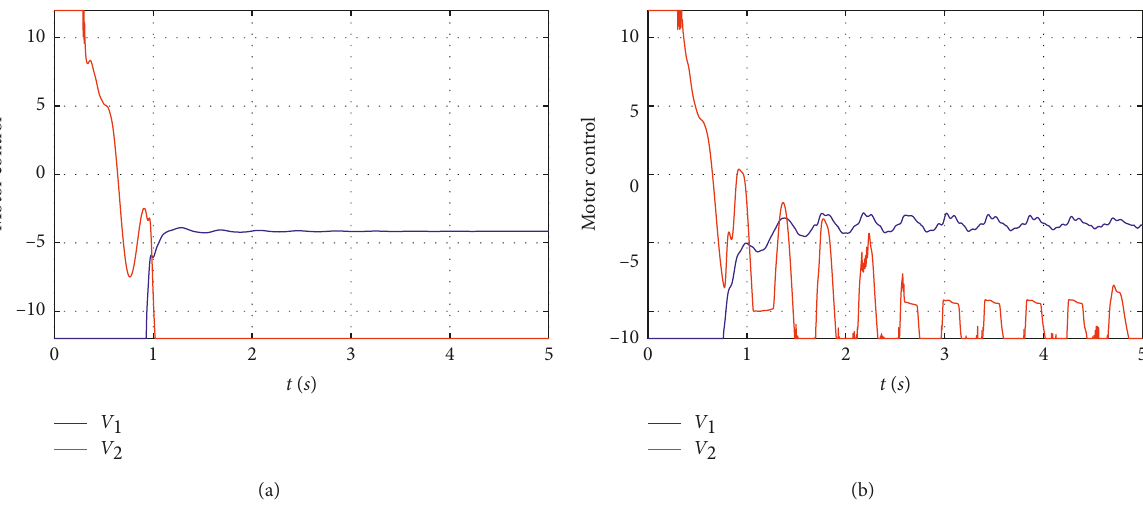
Figure 16: Voltage control of motor for control (a) without MR brake and (b) with MR brake.